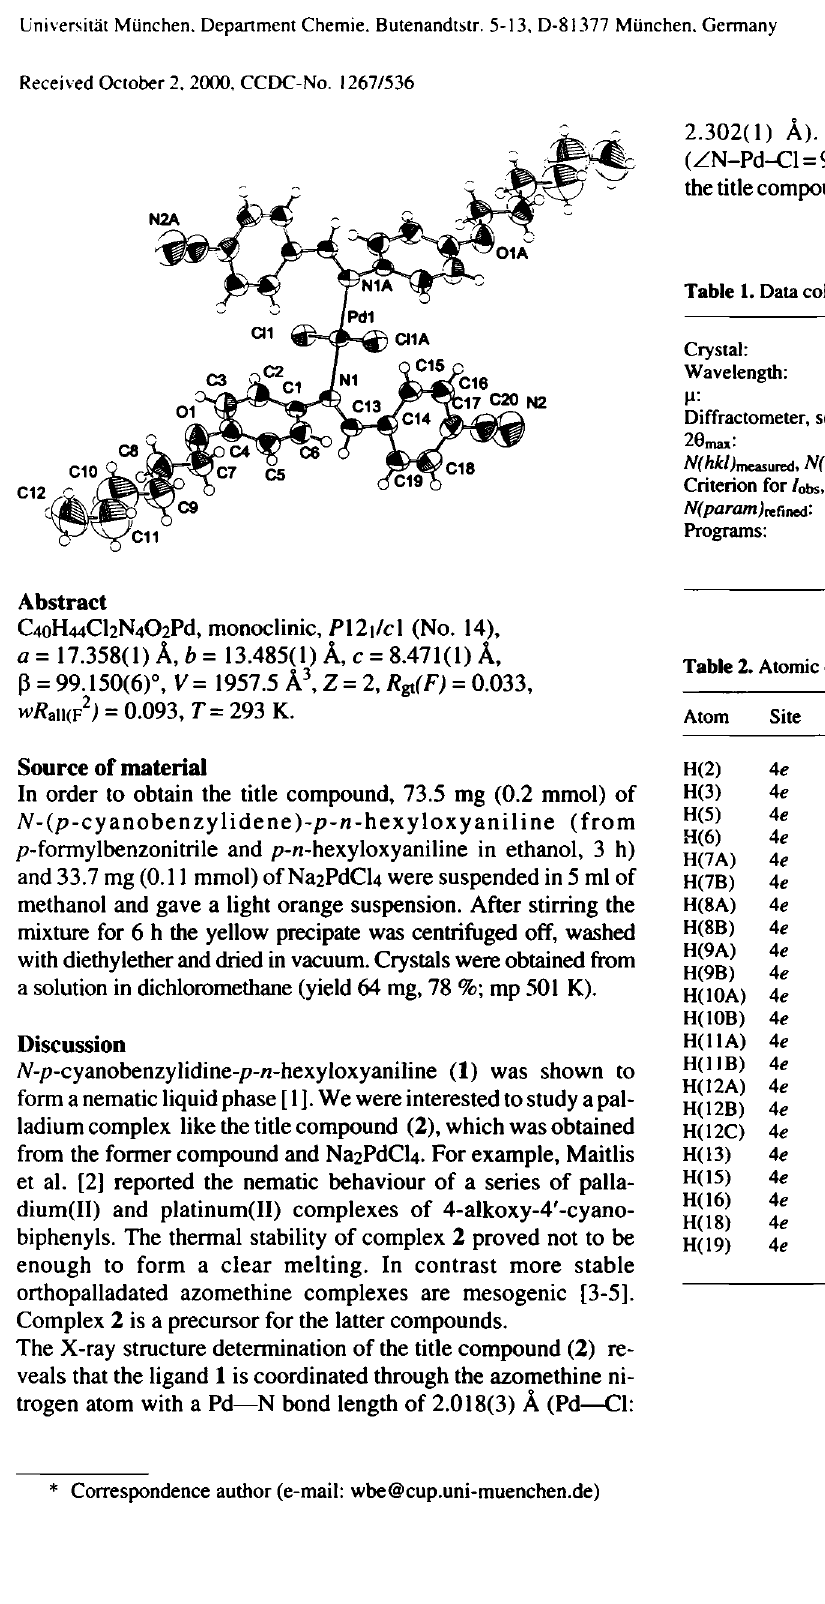
Table 1. Data collection and handling.